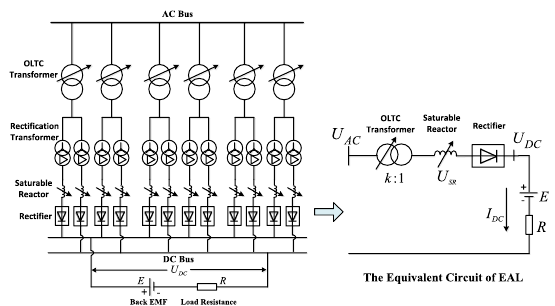
Fig. 3 The electrical diagram and the equivalent circuit of the